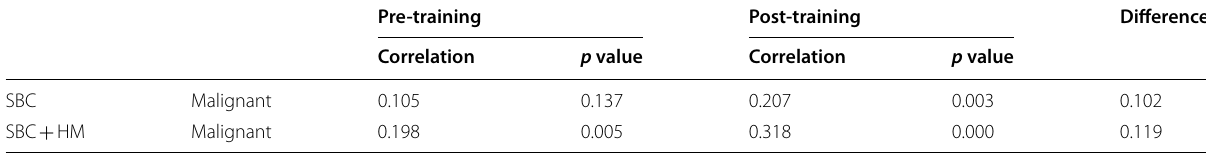
Table 2 Spearman’s rank correlations between the average human learner score pre‑ and post‑training of human observers, and the SBC/SBC HM malignancy probability +